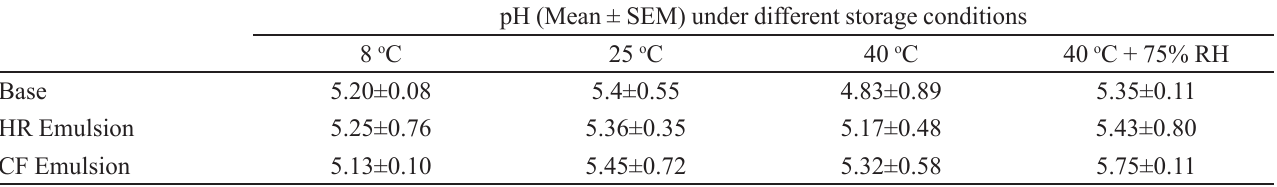
TABLE IV - Average pH Values of Base and Emulsions kept at 8 o C, 25 o C, 40 o C and 40 o C + 75% RH for a period of 2 months